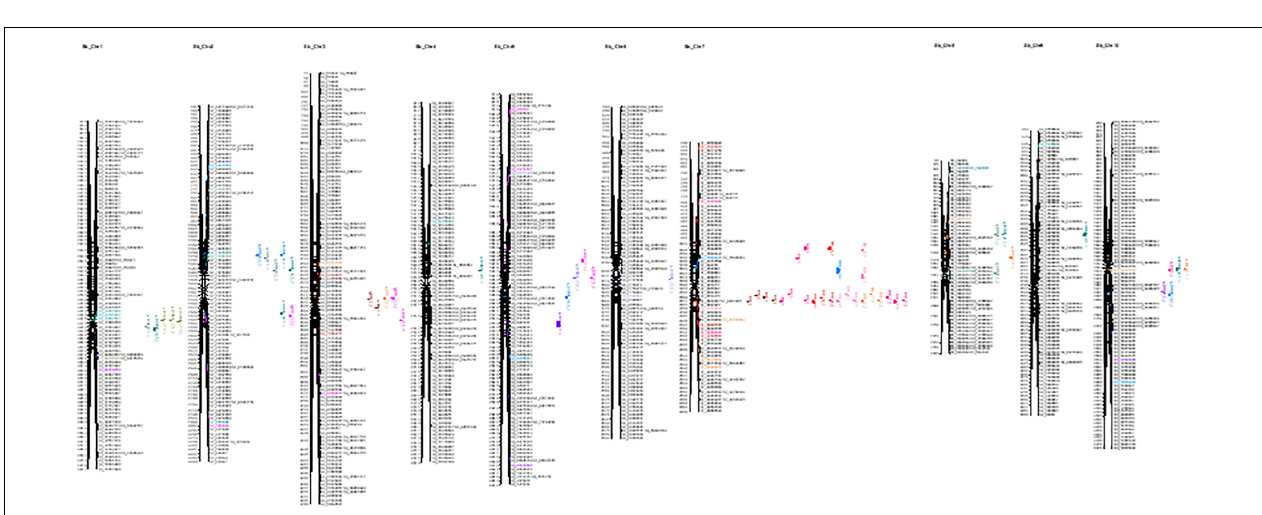
FIGURE 1 | Graphical representation of linkage groups on chromosome for all 11 traits under control and treatment for 2 years.